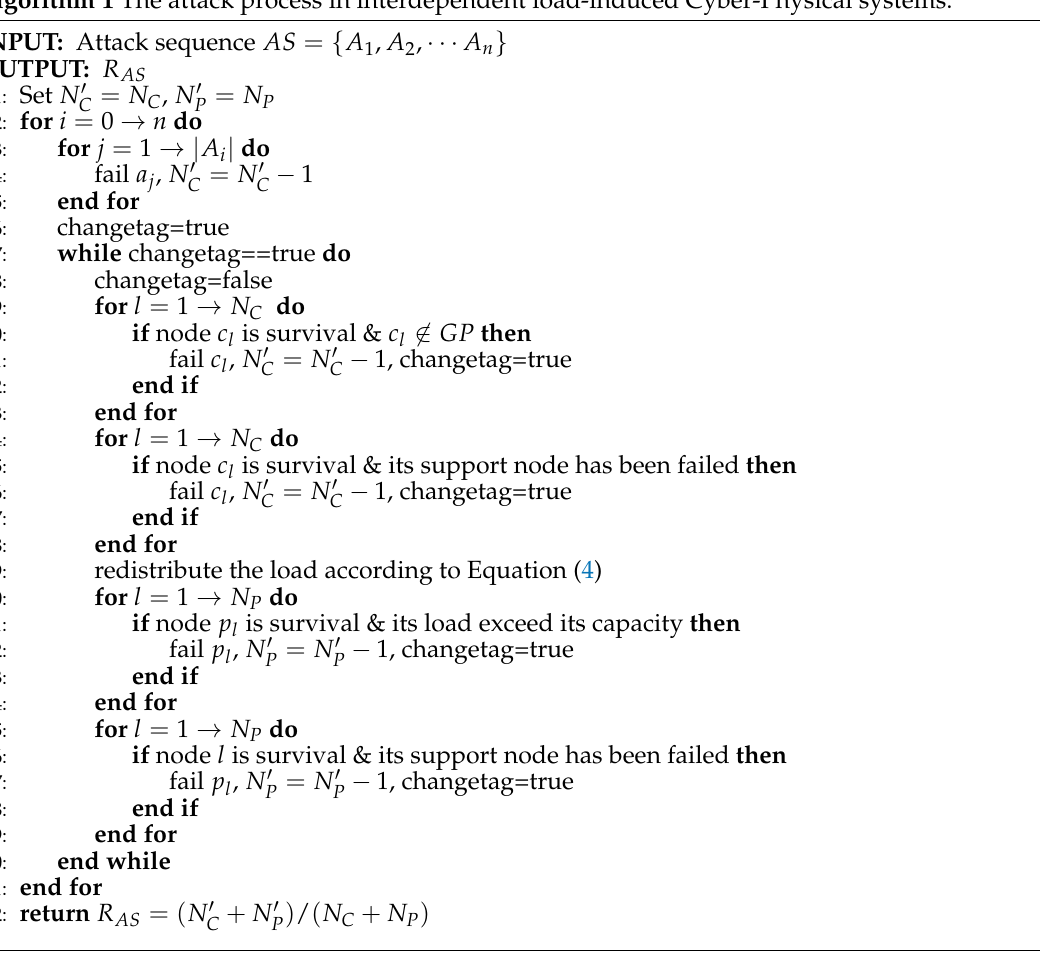
Algorithm 1 The attack process in interdependent load-induced Cyber-Physical